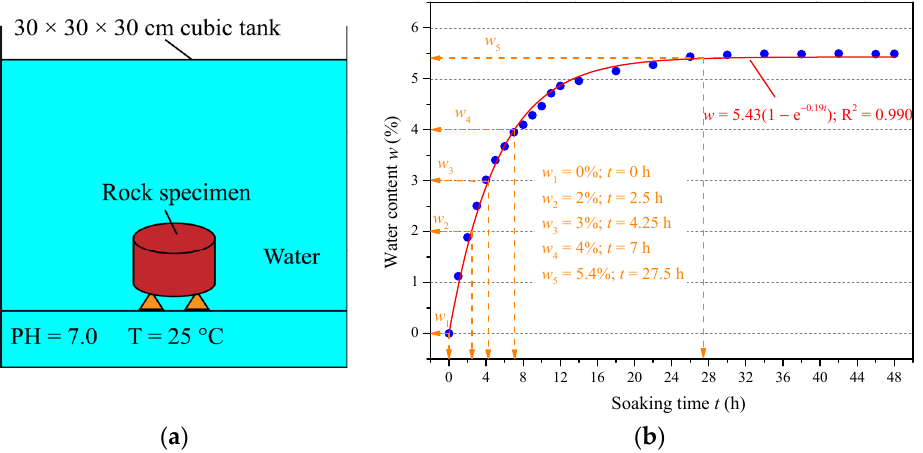
Figure 2. ( a ) schematic diagram of water immersion treatment method, ( b ) variation of water content vs. soaking time.